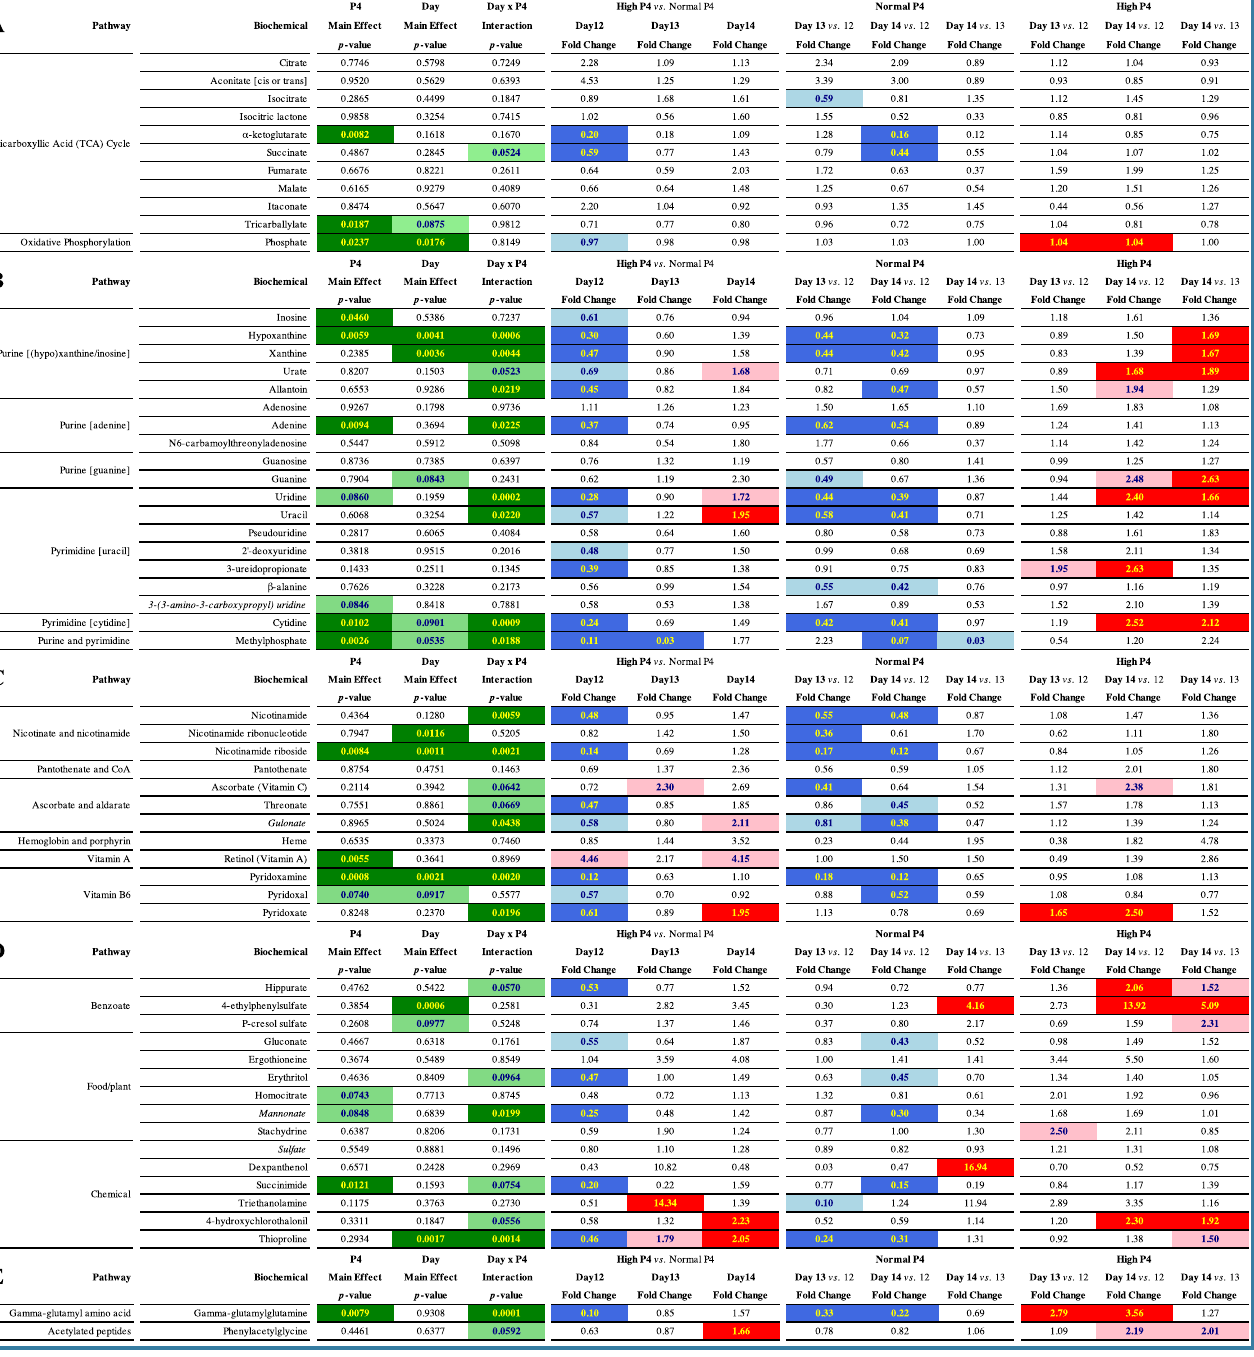
Table 1. Detected metabolites involved in ( A ) energy, ( B ) nucleotide, ( C ) vitamin and cofactor, ( D ) xenobiotic, and ( E ) peptide metabolism. Regarding day and/or progesterone main effects and/or day by progesterone interactions (first three columns), light green shading highlights a trend towards a significant (0.05 < p < 0.10) effect, whereas dark green shading highlights a statistically significant (p ≤ 0.05) effect with individual p-values provided within cells. Remaining columns comprise individual metabolite fold changes: dark blue shading indicates a significant (p ≤ 0.05) decrease (metabolite ratio < 1.0) between groups shown, whereas light blue depicts a decreasing trend (0.05 < p < 0.10). Conversely, dark red shading indicates a significant (p ≤ 0.05) increase (metabolite ratio ≥ 1.0) between groups shown with light red depicting an increasing trend (0.05 < p < 0.10). Non-coloured cells and text indicate the mean fold-change value was not significantly different for that comparison. Italics denotes predicted metabolites. Abbreviations: progesterone (P4) and coenzyme A